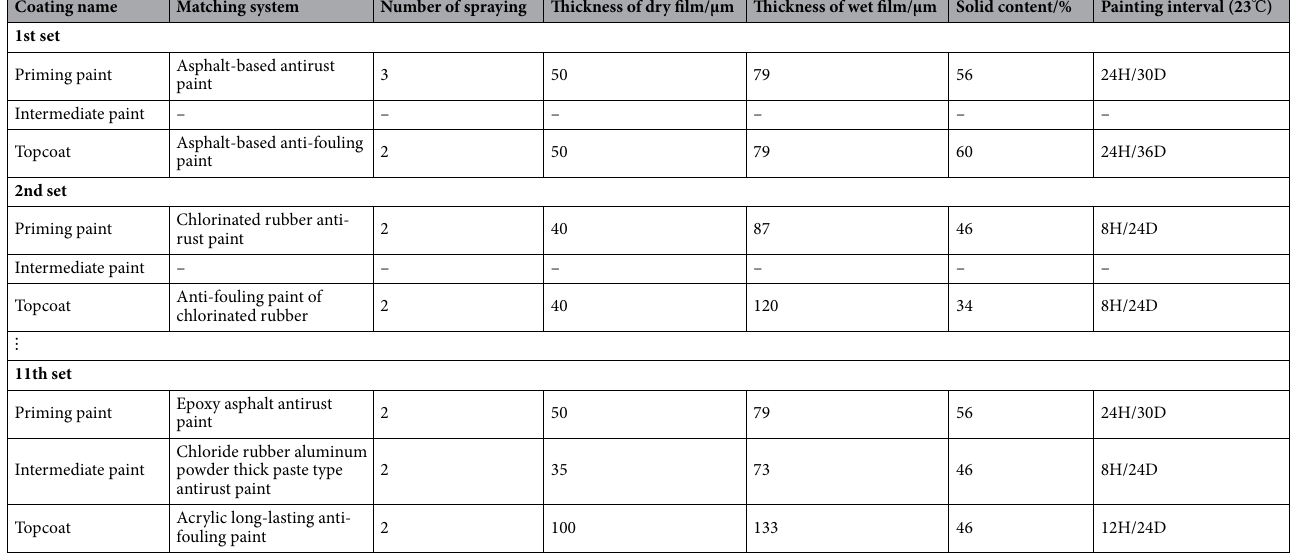
Table 9. Common coating matching for flat bottom